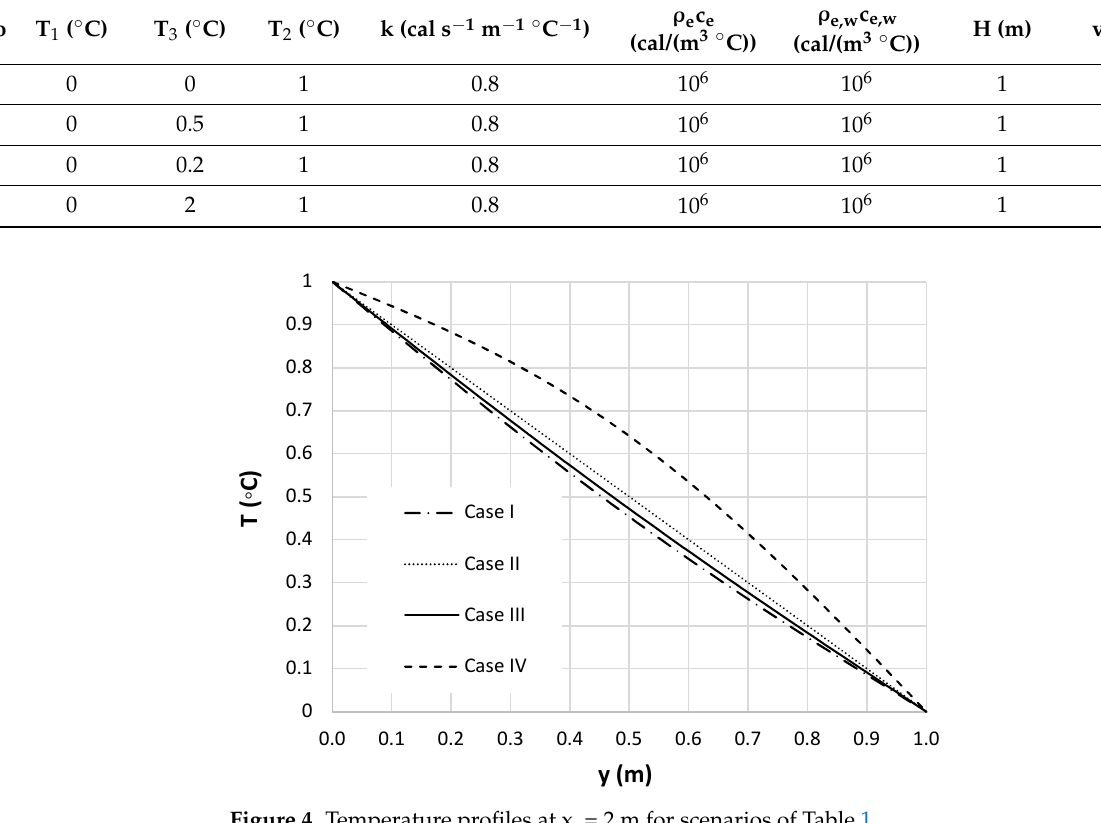
Figure 4. Temperature profiles at x = 2 m for scenarios of Table 1. Table 1. Parameters of typical scenarios whose patterns are shown in Figure 3.